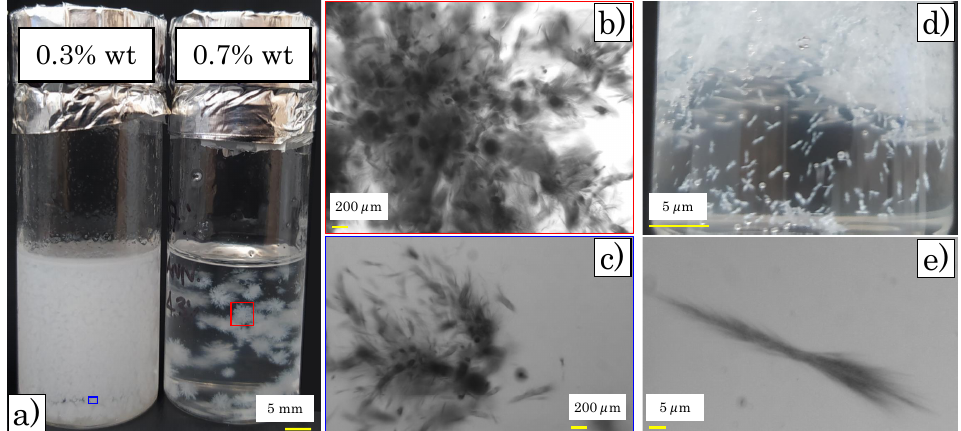
Figure 1. ( a ) Images of samples M2 at Carbopol concentrations of 0.3% wt (left) and 0.7% wt (right) taken after two weeks from sample initial preparation. ( b – c ) Brightfield images (upright optical microscope, Zeiss Axio Scope.A1) of a crystal isolated from the samples M2 at 0.7% wt ( b ) and at 0.3% wt ( c ) of Carbopol. ( d ) Detail of sample M1 at Carbopol concentration of 0.9% wt. ( e ) Brightfield image of a single crystal isolated from sample M1 reported in panel ( d